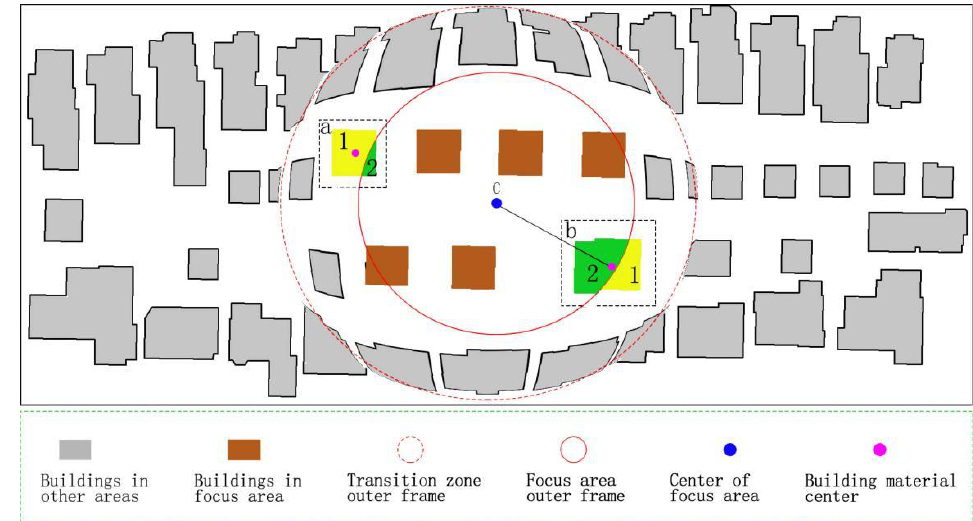
Figure 12. Removing the boundary conflicts.